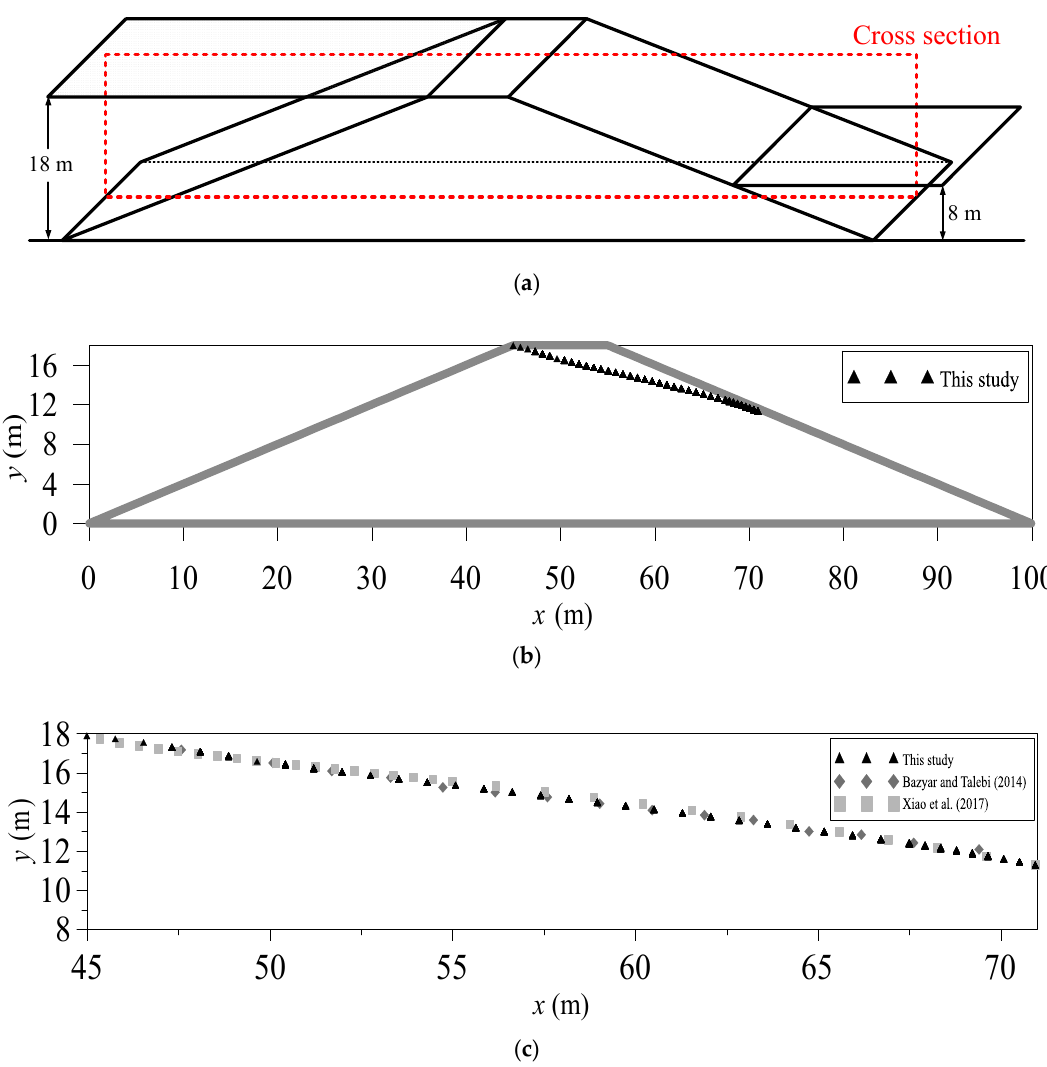
Figure 19. ( a ) The selected cross section, ( b ) computed free surface of an earth dam on profile 5.2 = y and ( c ) result comparison on profile 5.2 = y .